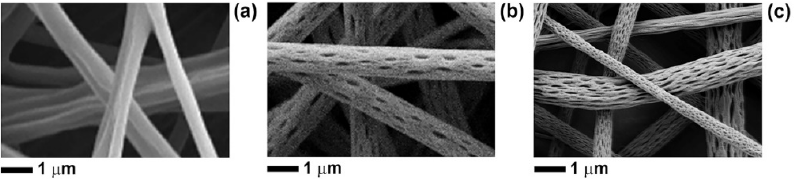
Figure 1. Selection of SEM micrographs of ( a ) PLA fibres, ( b ) PLA-BP fibres, and ( c ) PLA-limonene fibres to show the surface features.